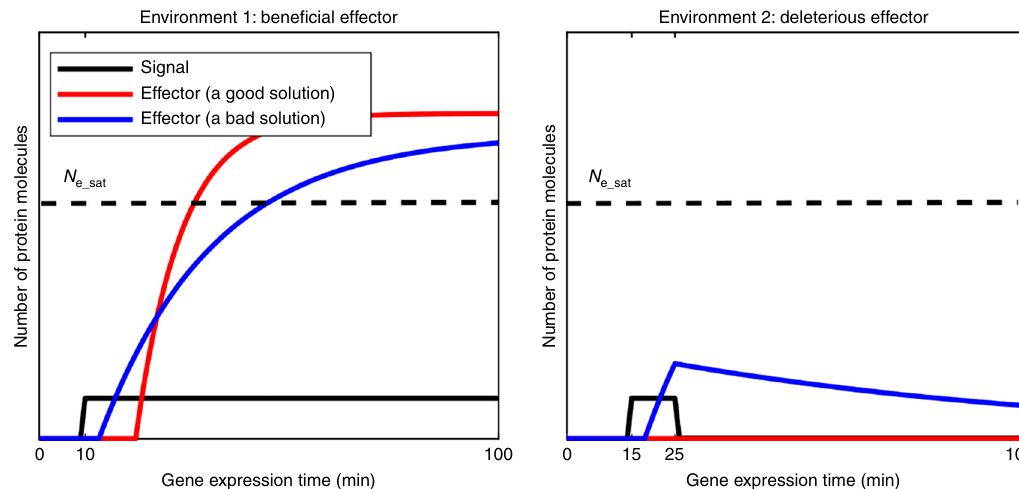
Fig. 3 Selection for fi ltering out short spurious signals. Each selection condition averages fi tness across simulations in two environments. The effectors have different fi tness effects in the two environments, and the signal also behaves differently in the two environments. Simulations begin with zero mRNA and protein, and all genes at the Repressed state (see Methods). Each simulation is burned in for a randomly sampled length of time in the absence of signal (shown here as 10 min in environment 1, and 15 min in environment 2), and continues for another 90 min after the burn-in. The signal is shown in black. Red illustrates a good solution in which the effector responds appropriately in each of the environments, while blue shows an inferior solution. N e_sat marks the amount of effector protein at which the bene fi t from expressing the effector in environment 1 becomes saturated, as does the damage in environment 2 (see Methods). See Supplementary Fig. 3 for examples of high- fi tness and low- fi tness evolved phenotypes, where, as shown in this schematic, high- fi tness solutions have longer delays followed by more rapid responses